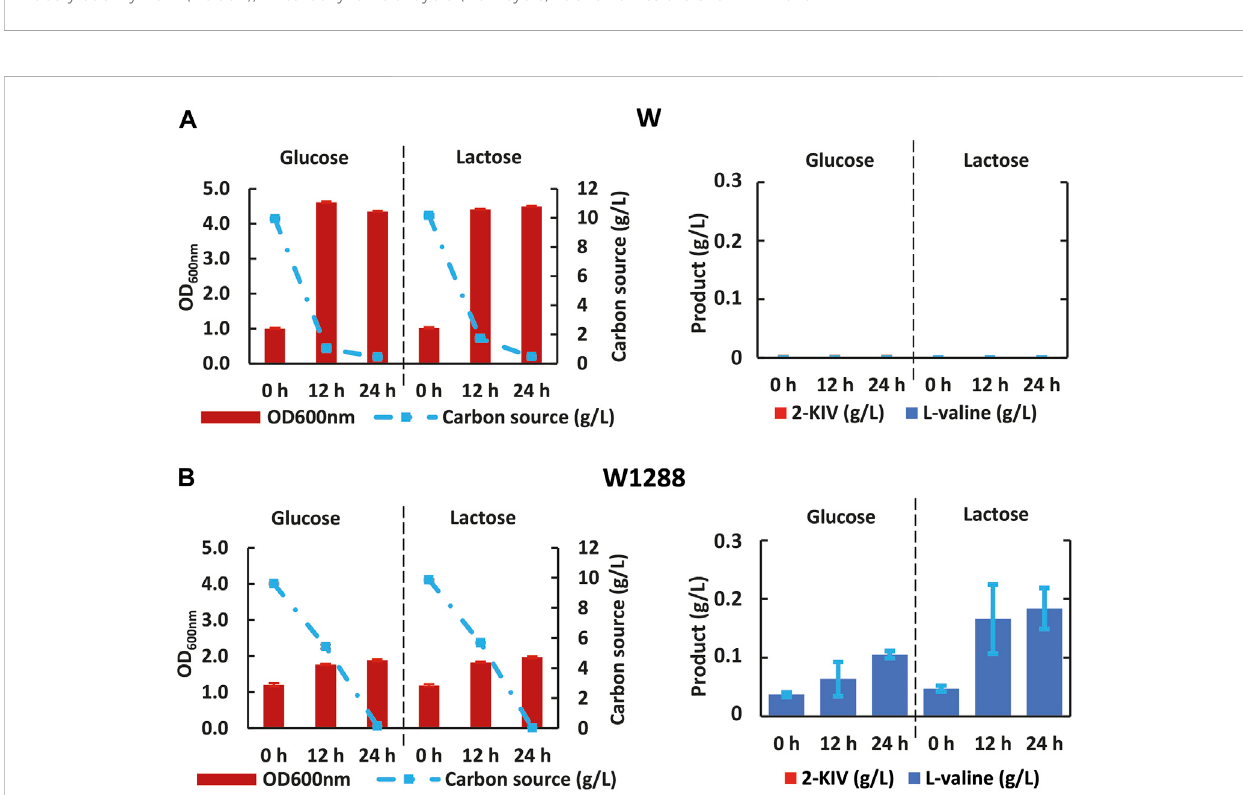
FIGURE 6 Kinetic of growth, substrate uptake and 2-ketoisovalerate and L-valine production of E. coli W (A) and E. coli W1288 (B) in shake fl ask experiments using glucose and lactose. Error bars indicate the difference between replicate cultures.